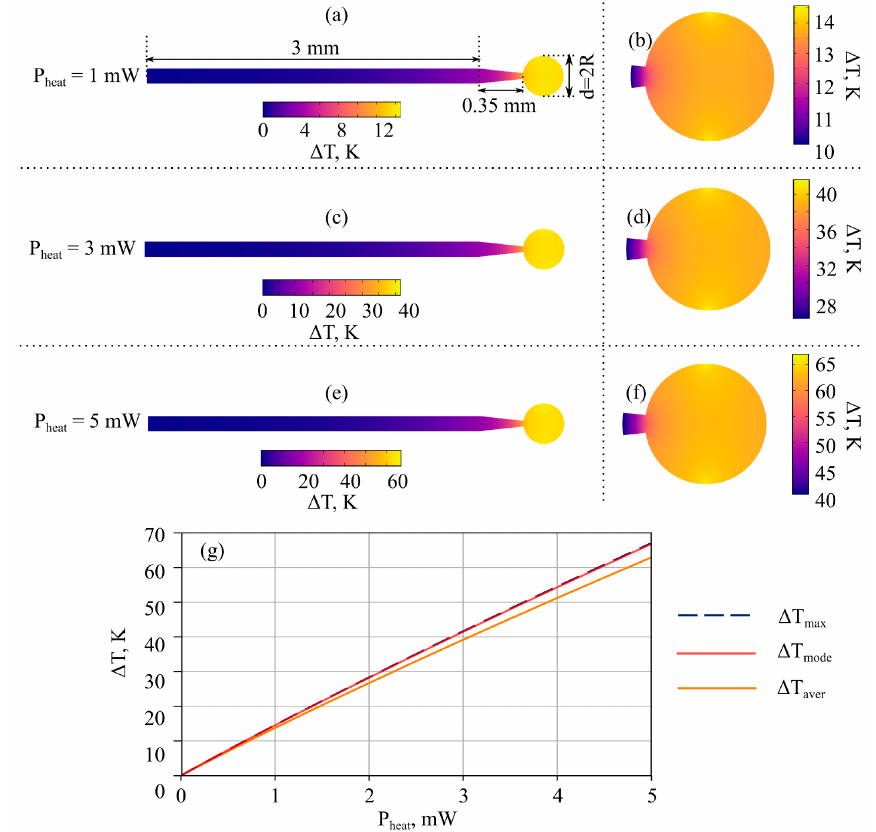
Figure 6. Temperature distributions for heat powers: 1 mW ( a , b ); 3 mW ( c , d ); and 5 mW ( e , f ). The temperature increase as a function of heat power ( g ). All subfigures are calculated for a microsphere with a diameter of ~328.5 μ m.